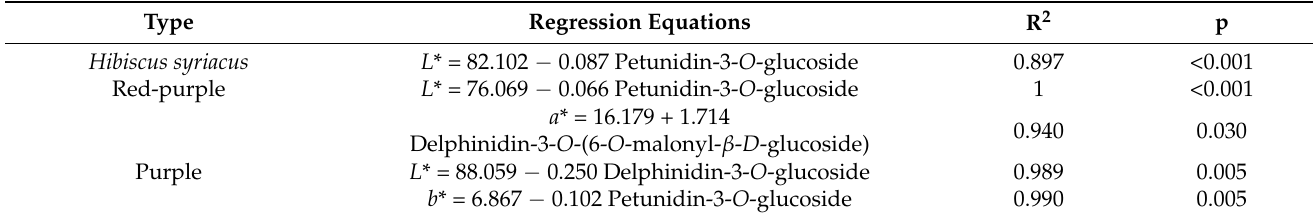
Table 3. Stepwise multiple regression equations of anthocyanin with L*, a*, and